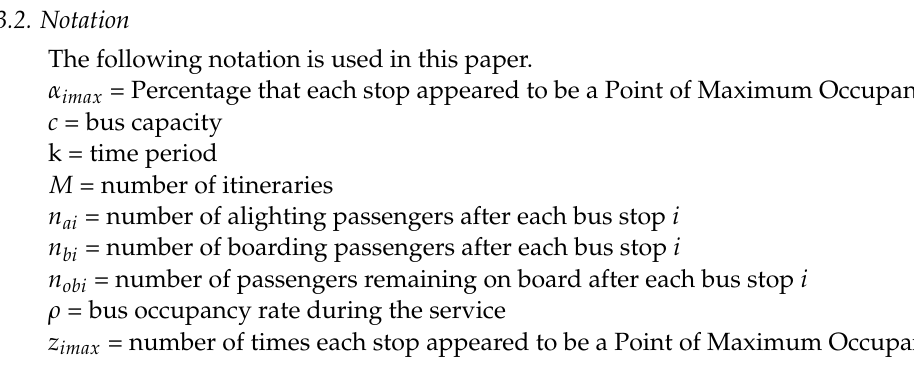
Figure 1. Map of Athens with the bus lines considered (Source: Google Maps).